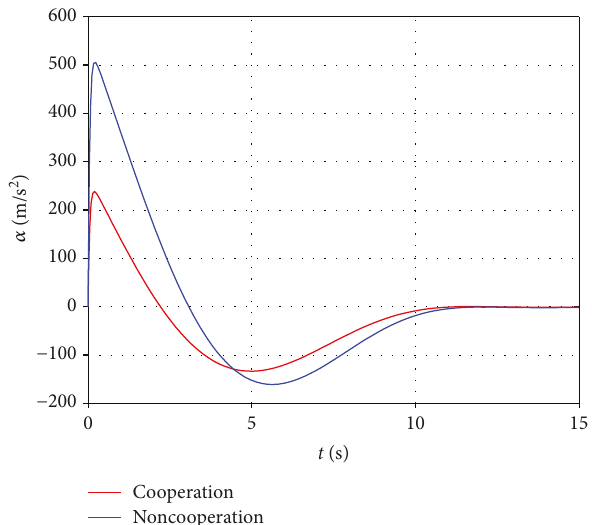
Figure 13: Acceleration variation of Defender 2 (one-side intercept).